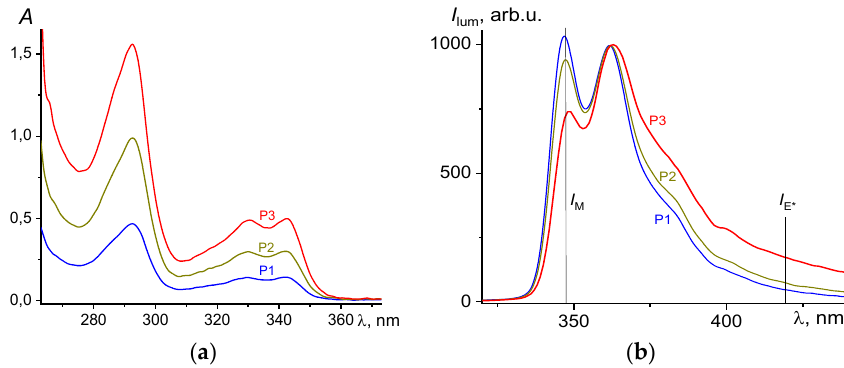
Figure 5. Absorption ( a ) and normalized emission ( b ) spectra of poly(VT- co -VK) copolymers in DMF by varying the VK content: 9 mol. % (P1), 16 mol. % (P2), and 37 mol. % (P3). Emission spectra are normalized at 360 nm.